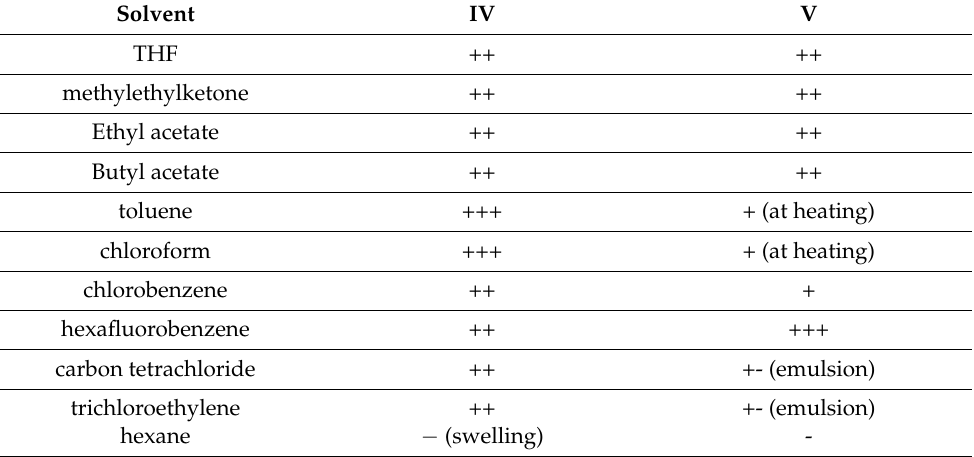
Table 1. Solubility of copolymers